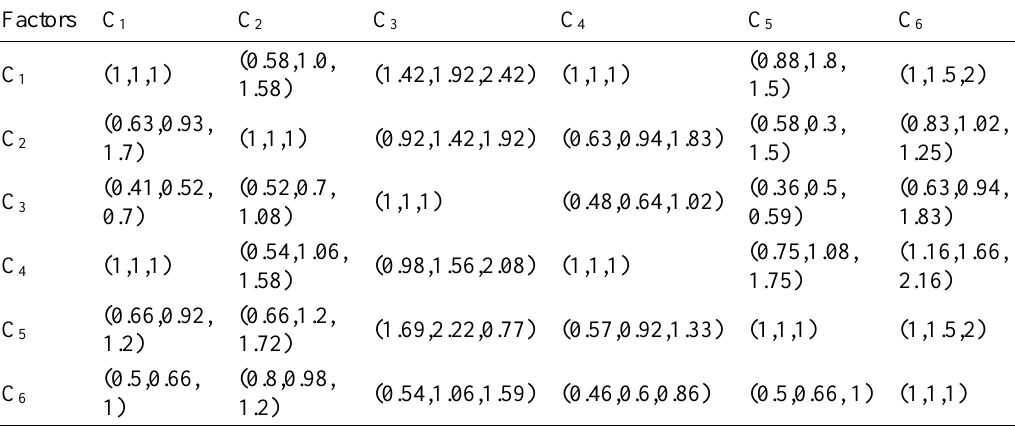
Table 2. Aggregated fuzzy pairwise comparison